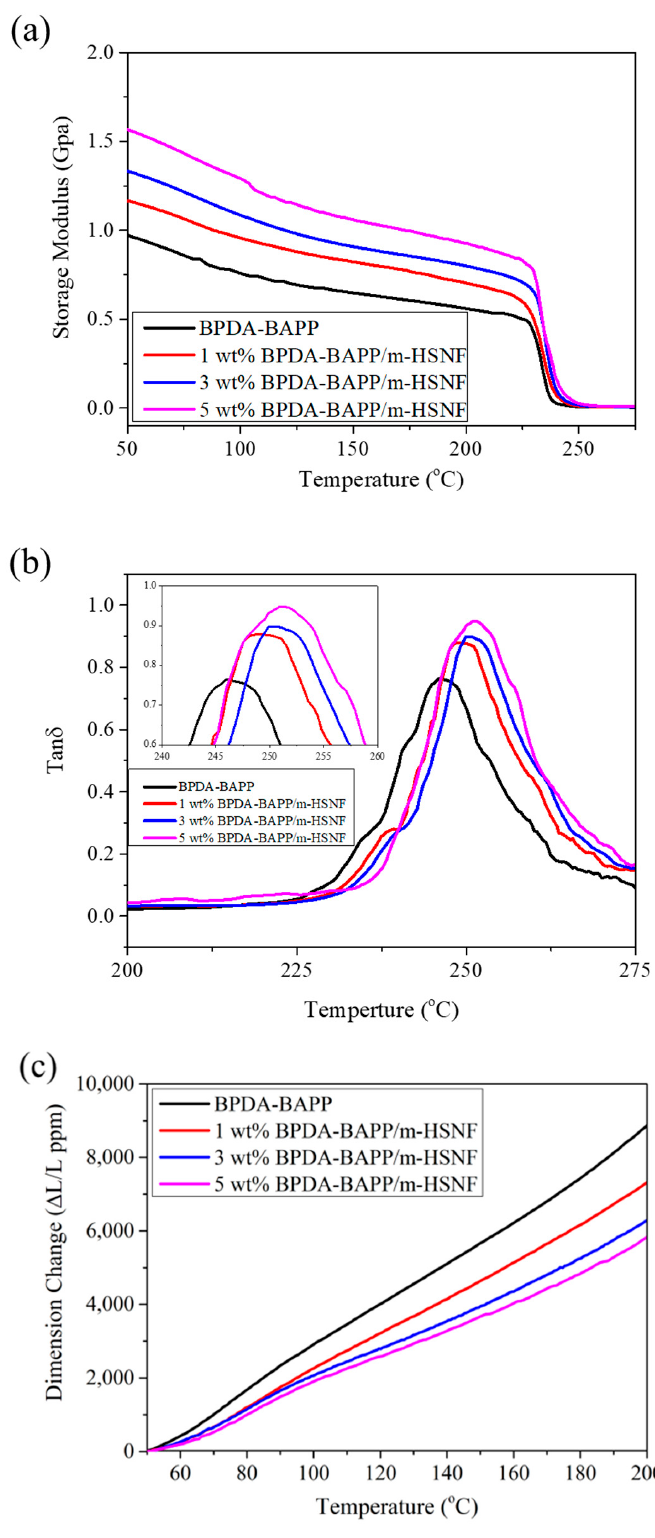
Figure 4. ( a ) Storage modulus E ′ , ( b ) tan δ , and ( c ) dimensional change against temperature of BPDA-BAPP/m-HSNF nanocomposites.